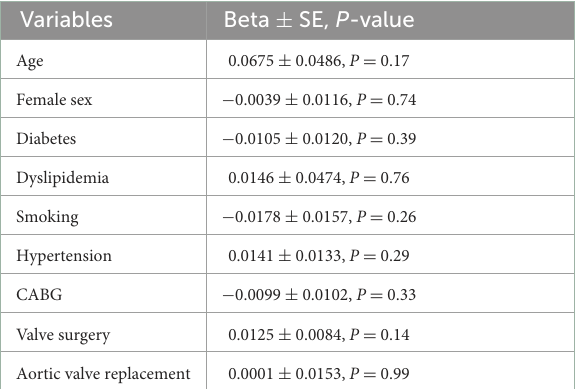
TABLE 3 Results of meta-regression for the primary